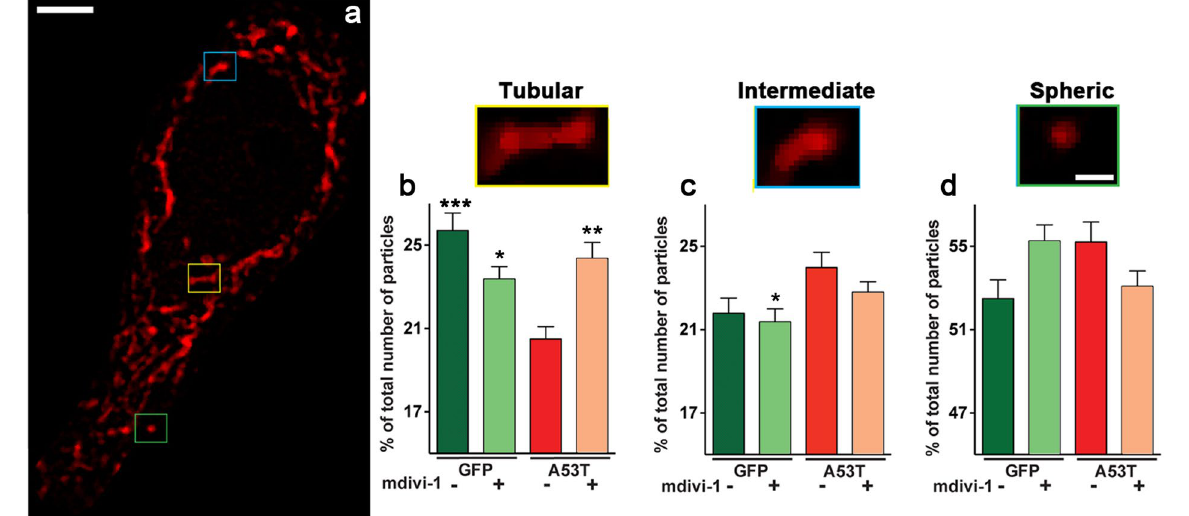
Figure 4. Mdivi-1 reduces mitochondrial fragmentation in dopaminergic neurons induced by hA53T- α - syn. Coronal midbrain sections containing SN of rats after 8 weeks of receiving AAV-hA53T- α -syn or AAV- GFPdegron with or without mdivi-1 treatment were immunostained with a mitochondrial marker HSP60 (red) and TH (not shown). Scale bar 5 μ m. Different mitochondrial morphologies were categorized into three populations according to their shapes: tubular, intermediate and spheric (representative pictures bottom panel a, scale bar 1 μ m). ( b,c,d ) Abundance in different mitochondria populations. Panel B shows a decrease in the relative number of tubular mitochondria in neurons of rats expressing hA53T- α -syn. This phenotype was reversed following mdivi-1 treatment. Fluorescent images were captured as single layer. Values are means ± SEM for 50–80 TH + neurons per group. Statistical analysis was performed using two-way ANOVA ( b ) AAV injection: F 1,246 = 8.144 p = 0.0047; treatment: F 1,246 = 1.069 p = 0.3023; AAV injection x treatment: F 1,246 = 17.47 p < 0.001;( c ) AAV injection: F 1,246 = 8.008 p = 0.005; treatment: F 1,246 = 1.569 p = 0.2115; AAV injection x treatment: F 1,246 = 0.3536 p = 0.5526) followed by Tukey multiple comparison test ( * p < 0.05; ** p < 0.01; *** p < 0.01 to A53T vehicle).